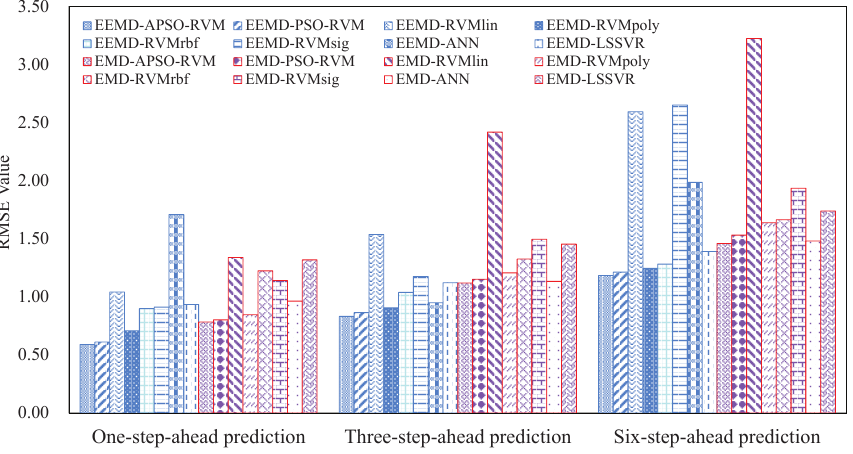
Figure 6. MAPE by different ensemble methods.